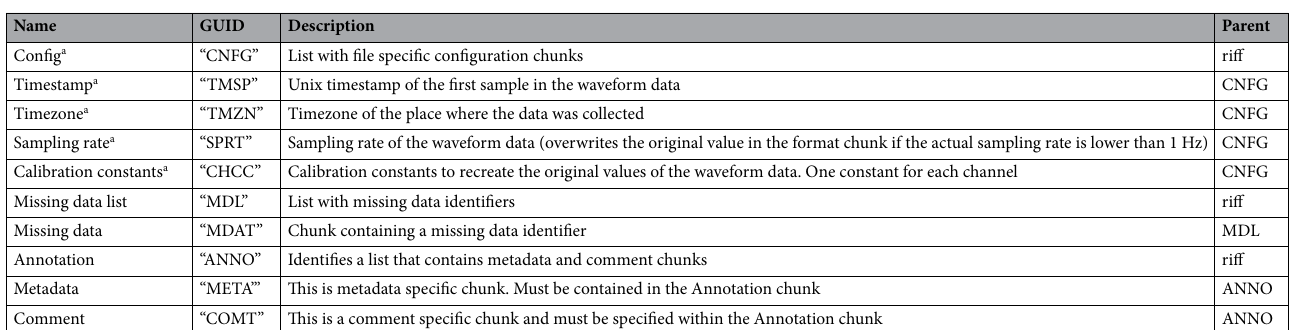
Table 2. List of EMD-DF64 specific chunks. a These chunks are